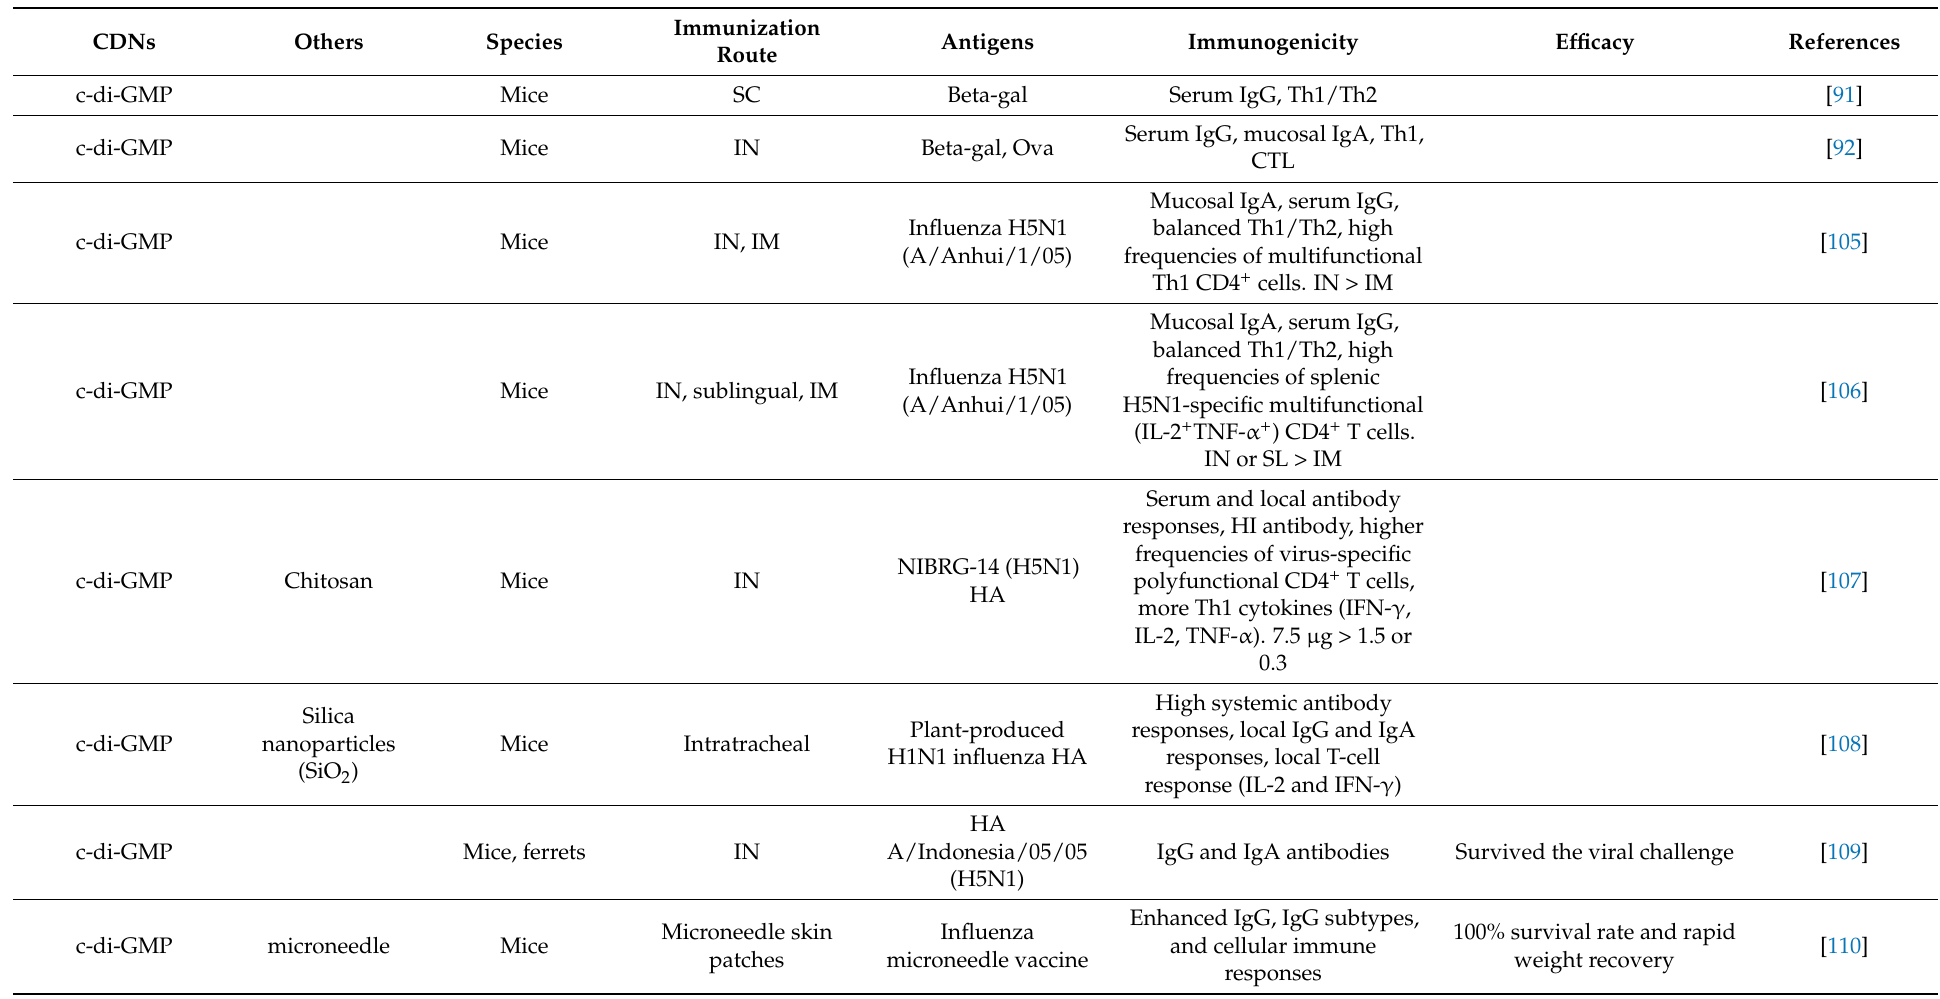
Table 1. Selected application of cyclic dinucleotides (CDNs) as adjuvants in the development of vaccines against infectious diseases and